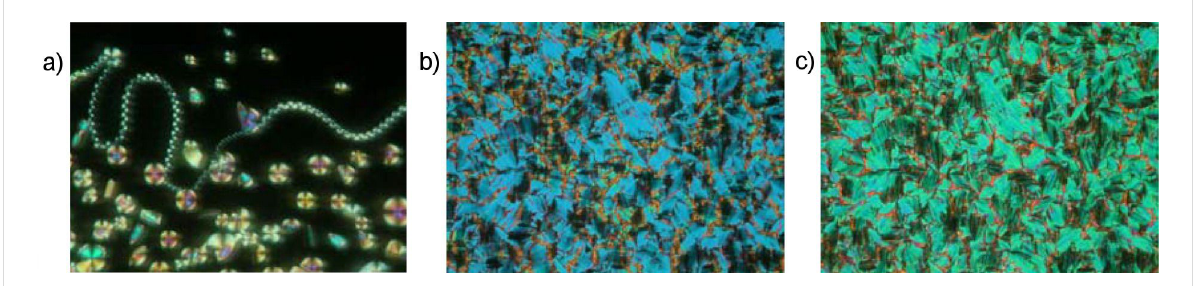
Figure 8: Optical photomicrographs of compound OH 3a : a) On cooling of the isotropic liquid; c) U = 0 V; b) U D.C. = ±67 V, T = 172 °C, d cell = 6 μ m.